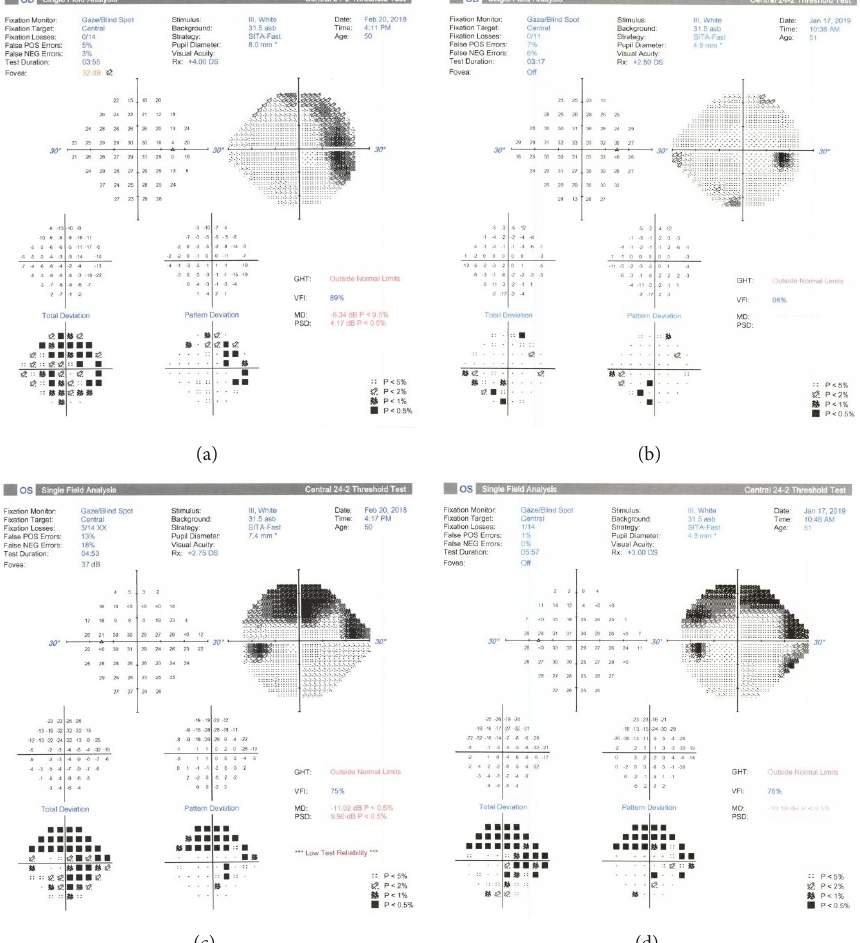
Figure 4: Humphrey visual field of the patient of the right eye shows scattered deficits both upon presentation (a) and almost one year later (b). A dense superior arcuate defect seen in the left eye on presentation (c) is consistent and has not progressed almost one year later (d). This superior arcuate defect corresponds to inferotemporal thinning of the retinal nerve fiber layer on OCT of the left